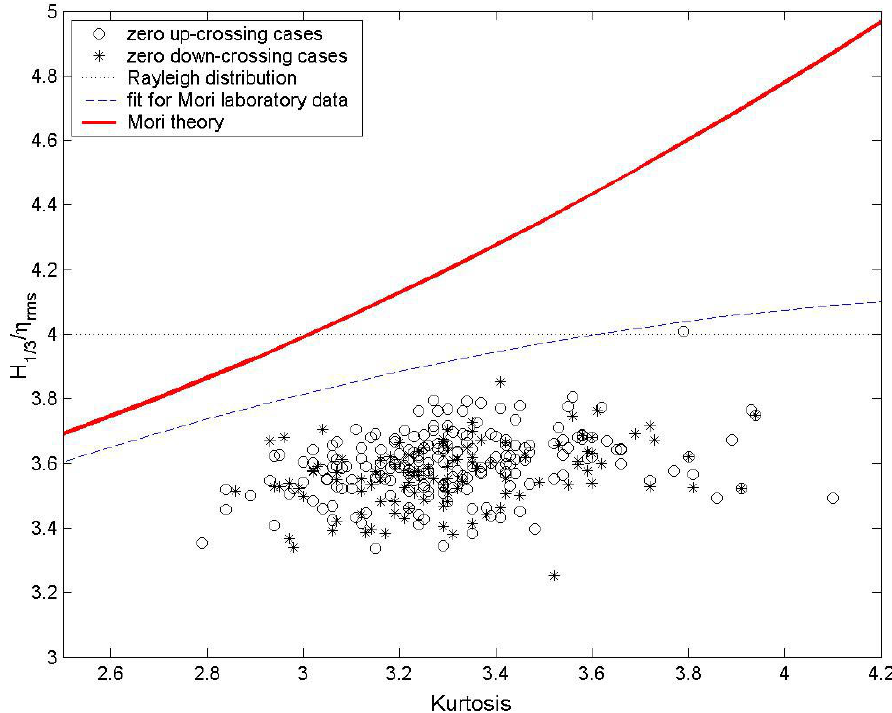
Fig. 4. Correlating H 1 / 3 / η rms with respect to Kurtosis to illustrate the ineptitude of the Rayleigh distribution as a basis for representing occurrence probability of freak